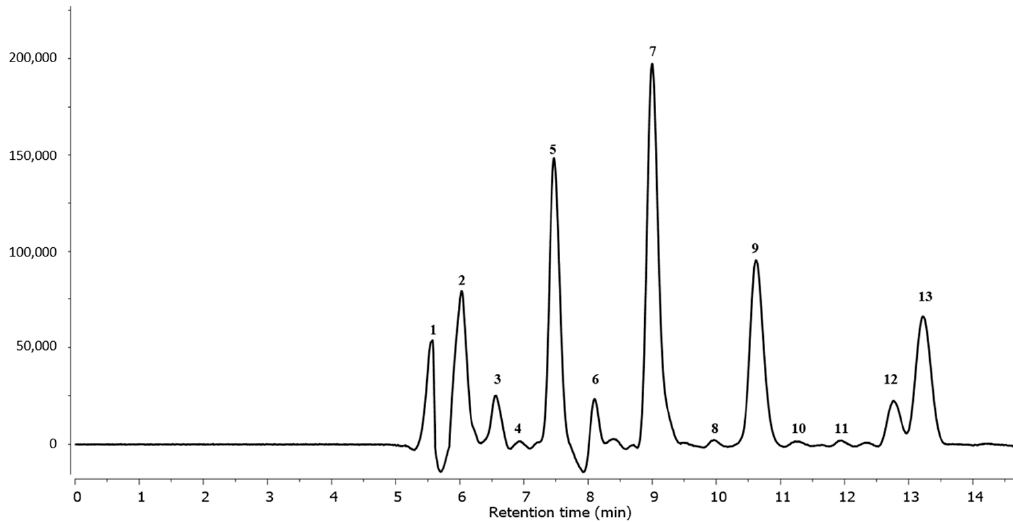
Figure 3. UPLC triterpenoids profile of G. lucidum extract at 254 nm. Peak number identities are displayed in Table 2.